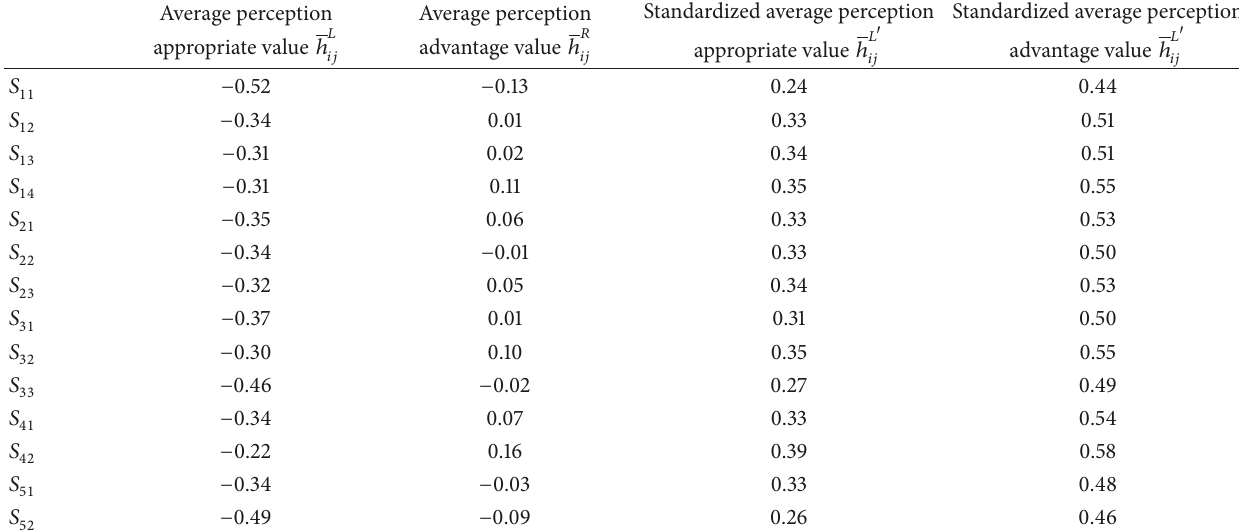
Table 7: Standardization of perception advantage value and perception appropriate value.